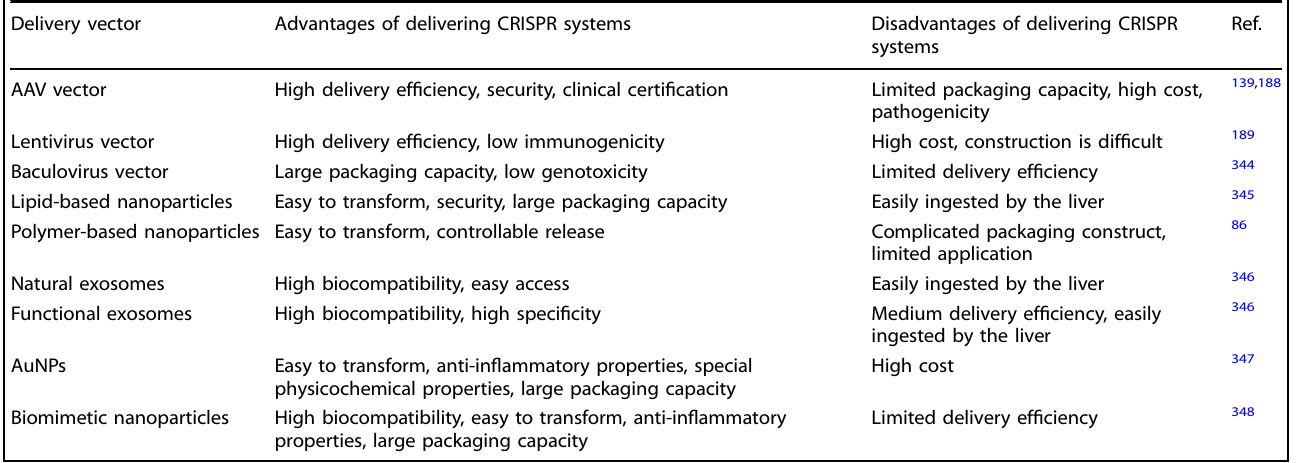
Table 3. Characteristics of various vectors loaded with the CRISPR/dCas9 system Delivery